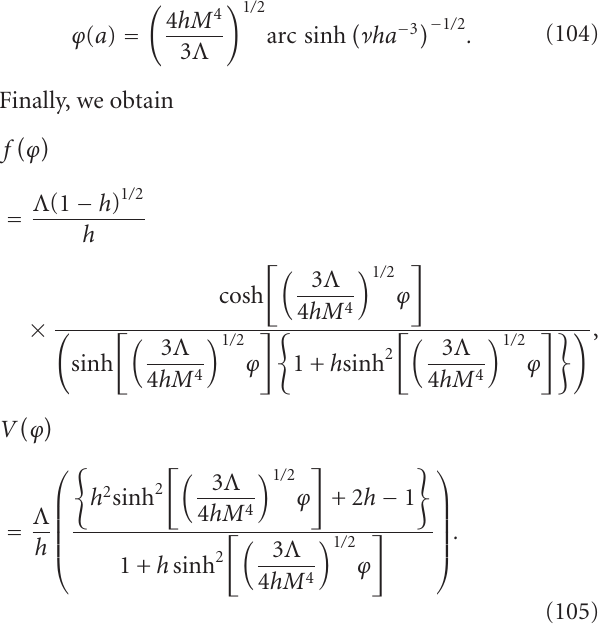
When a → ∞ , we have ϕ → ∞ and 2 X/M 4 → h